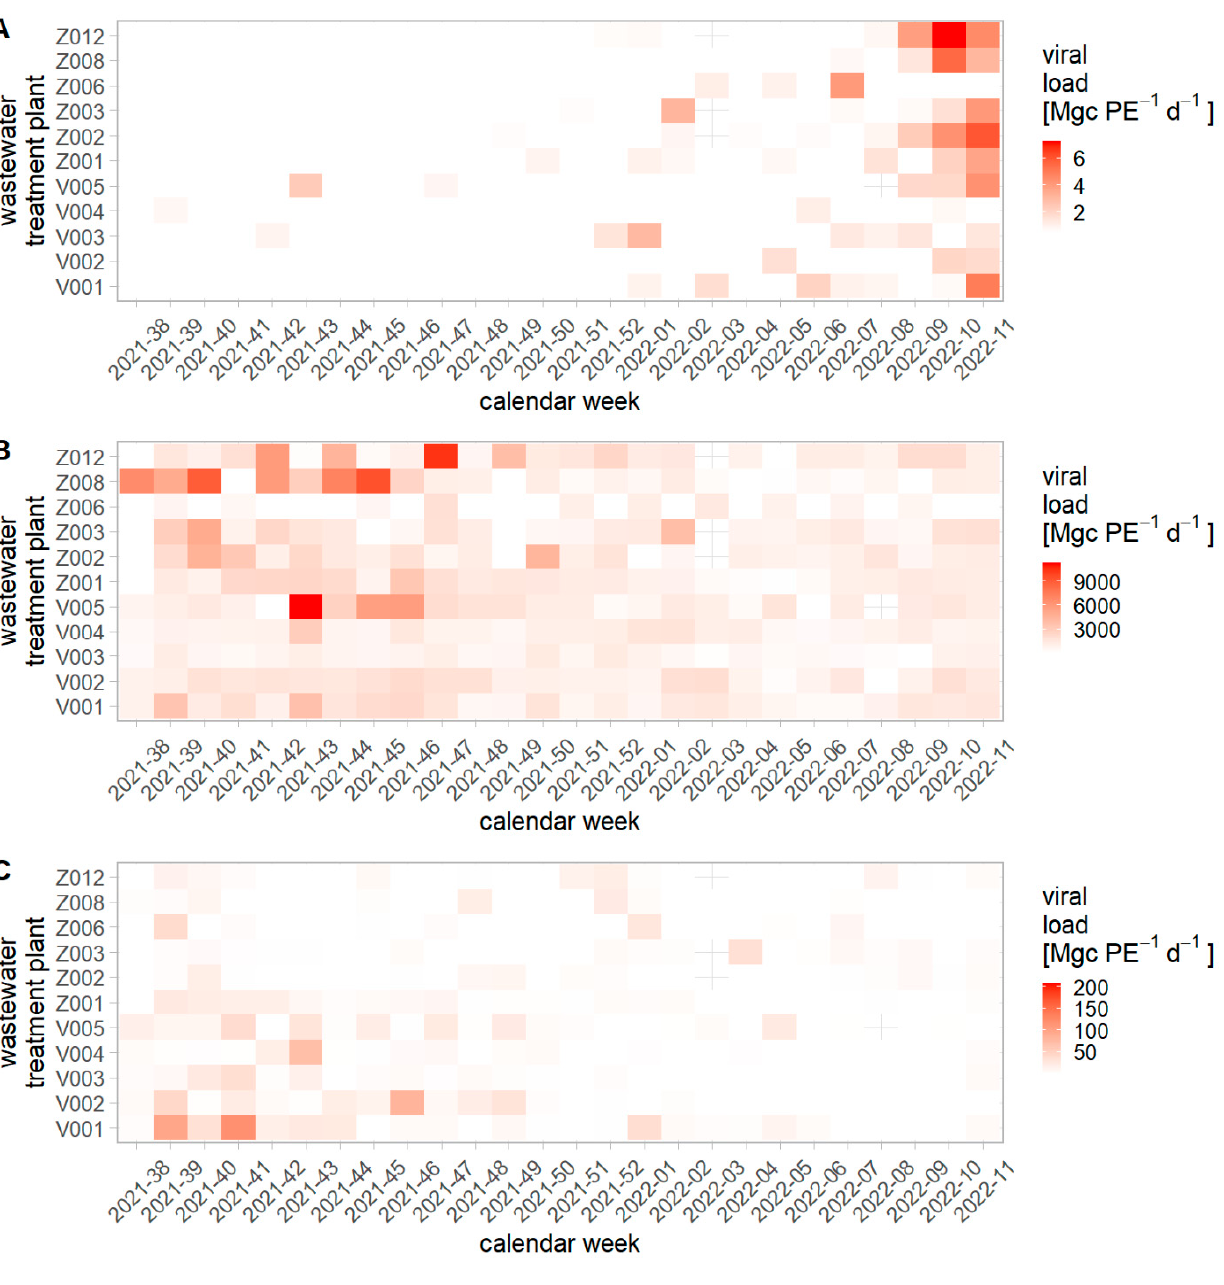
Figure 2. Normalized virus loads for ( A ) influenza A, ( B ) norovirus GII, and ( C ) norovirus GI per WWTP. More intense color corresponds to higher loads in wastewater. Each plot is scaled separately due to large discrepancy of absolute loads between pathogens. WWTP V001–V005 correspond to the federal state Vorarlberg and WWTPs Z001–Z012 correspond to the federal state Salzburg.